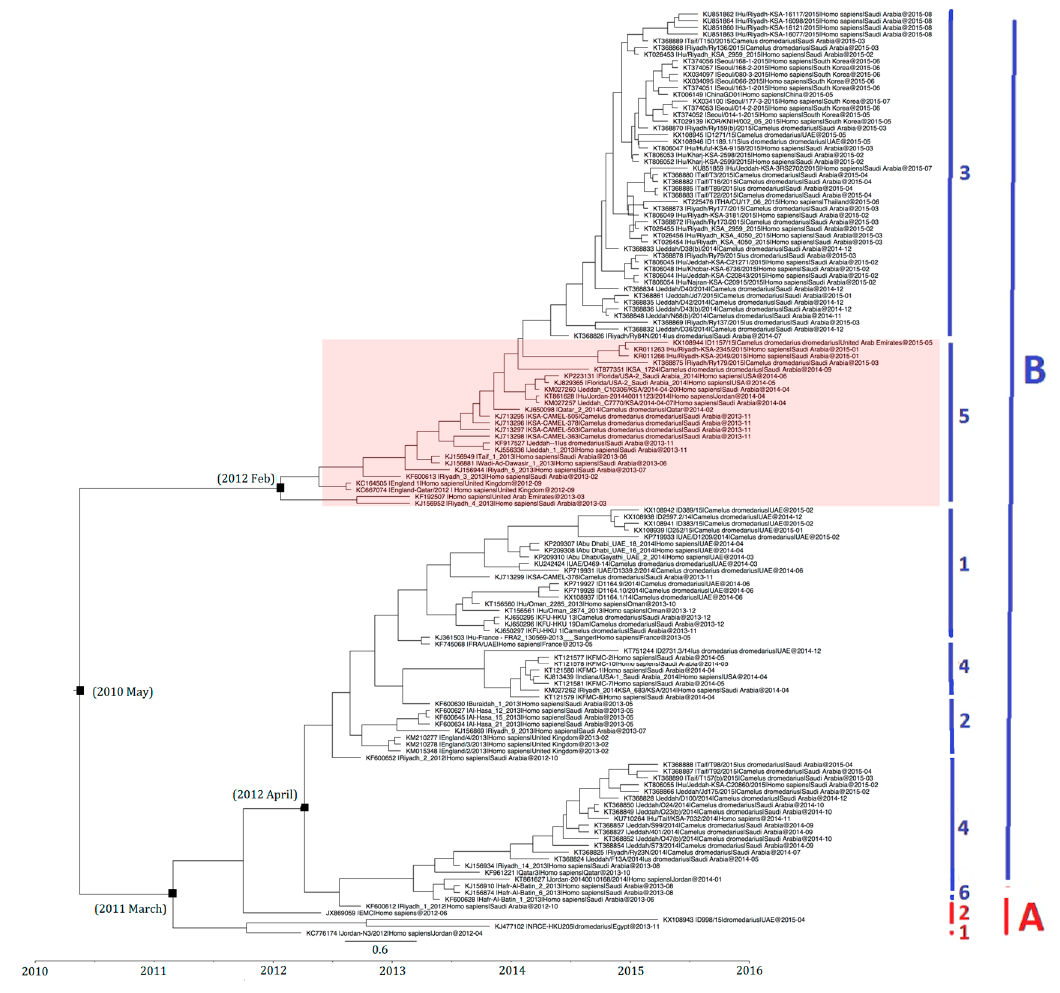
Figure 7. Estimation of time to the most recent common ancestor for MERS-CoV. The time-scaled phylogeny was summarized from all Markov chain Monte Carlo phylogenies of the concatenated coding region S of 138 phylogenetically distinct MERS-CoV genomes, which were analyzed under the relaxed-clock model with an uncorrelated exponential distribution in BEAST version 1.7.4. The clade B lineage 5 MERS-CoV is highlighted. Different colored letters and numbers represent different clades and lineages respectively: red letter, clade A; red number, lineages within clade A; blue letter, clade B; blue numbers, lineages within clade B.